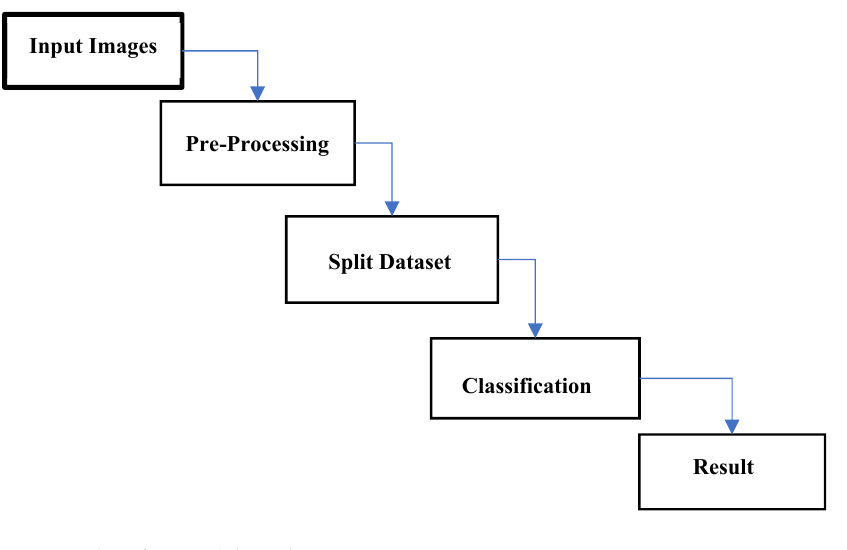
Figure 2. Classifier model used.